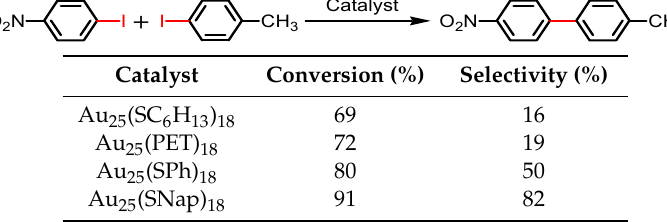
Table 2. The catalytic results over the Au 25 (SR) 18 /CeO 2 catalysts in Ullmann hetero-coupling. Reaction